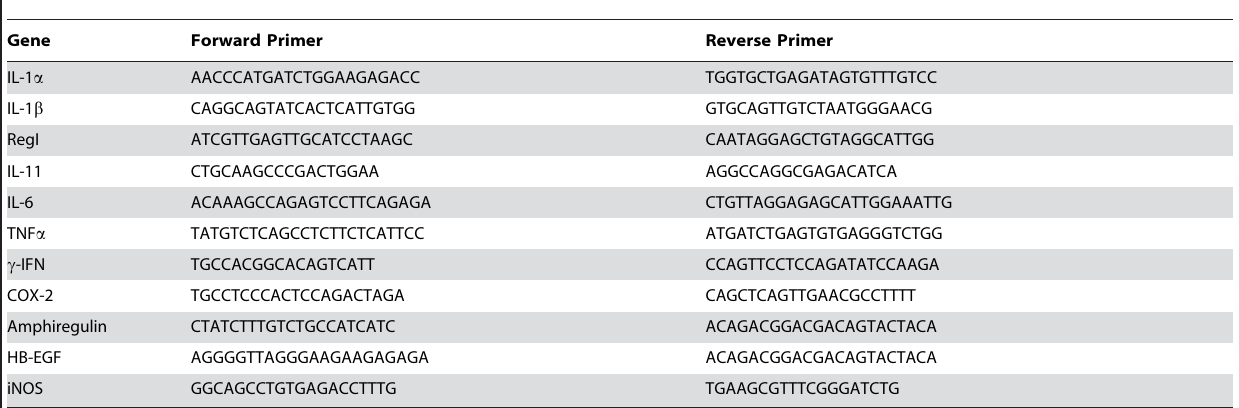
Table 1. Primer sequences used for mRNA expression analysis by QRT-PCR.